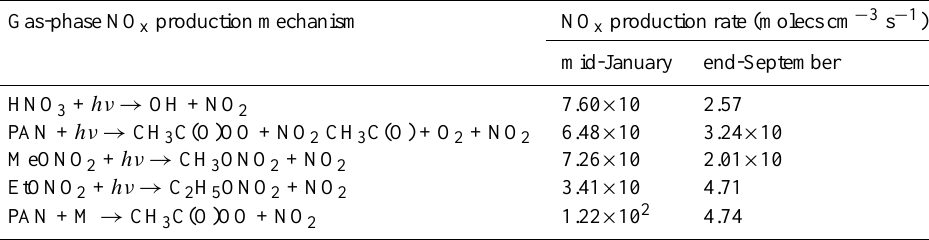
Table 2a. 24-h average NO x production rates calculated from various mechanisms for 18 January 2005 and 28/29 September 2004. Gas-phase NO x production mechanism